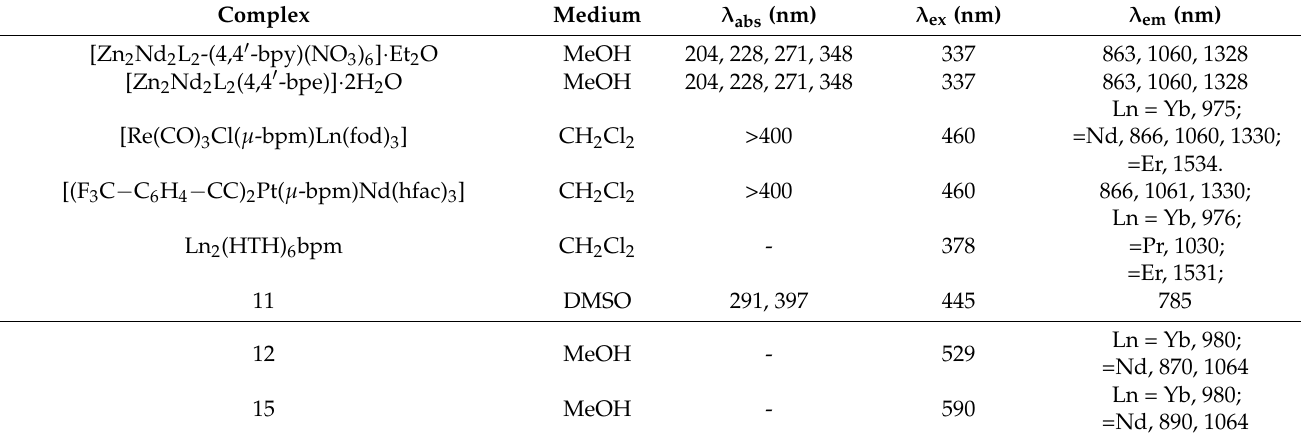
Table 1. Photophysical data for some complexes that were mentioned in this chapter.